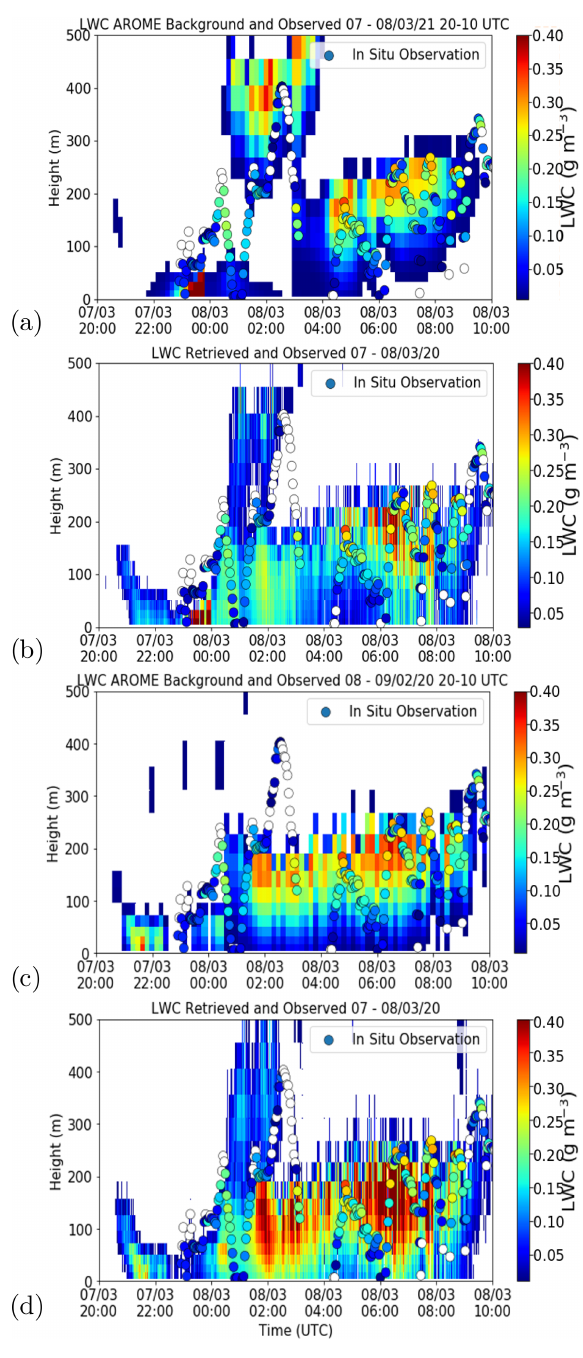
Figure 7. Background and retrievals of LWC from the fog case on 7–8 March 2020 using the nearest background and the MRP back- ground. Panel (a) shows the LWC predicted by the AROME model, panel (b) shows the retrieval of LWC made with the 1D-Var al- gorithm using both radar and microwave radiometer measurements from the nearest background, panel (c) shows the MRP background, and panel (d) shows retrievals as made from the MRP background. The circles in all plots show the in situ measurements made by the CDP of LWC. The configuration where Jacobians are forced to be positive was